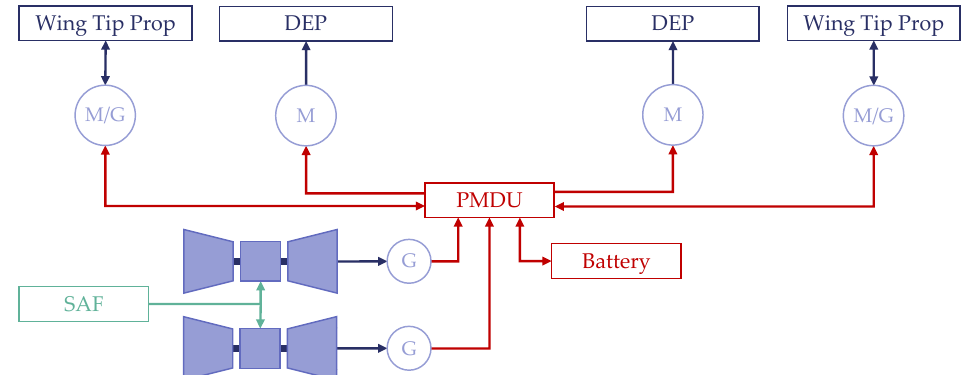
Figure A4. Architecture 4: Serial hybrid-electric architecture powering DEP and WTPs.